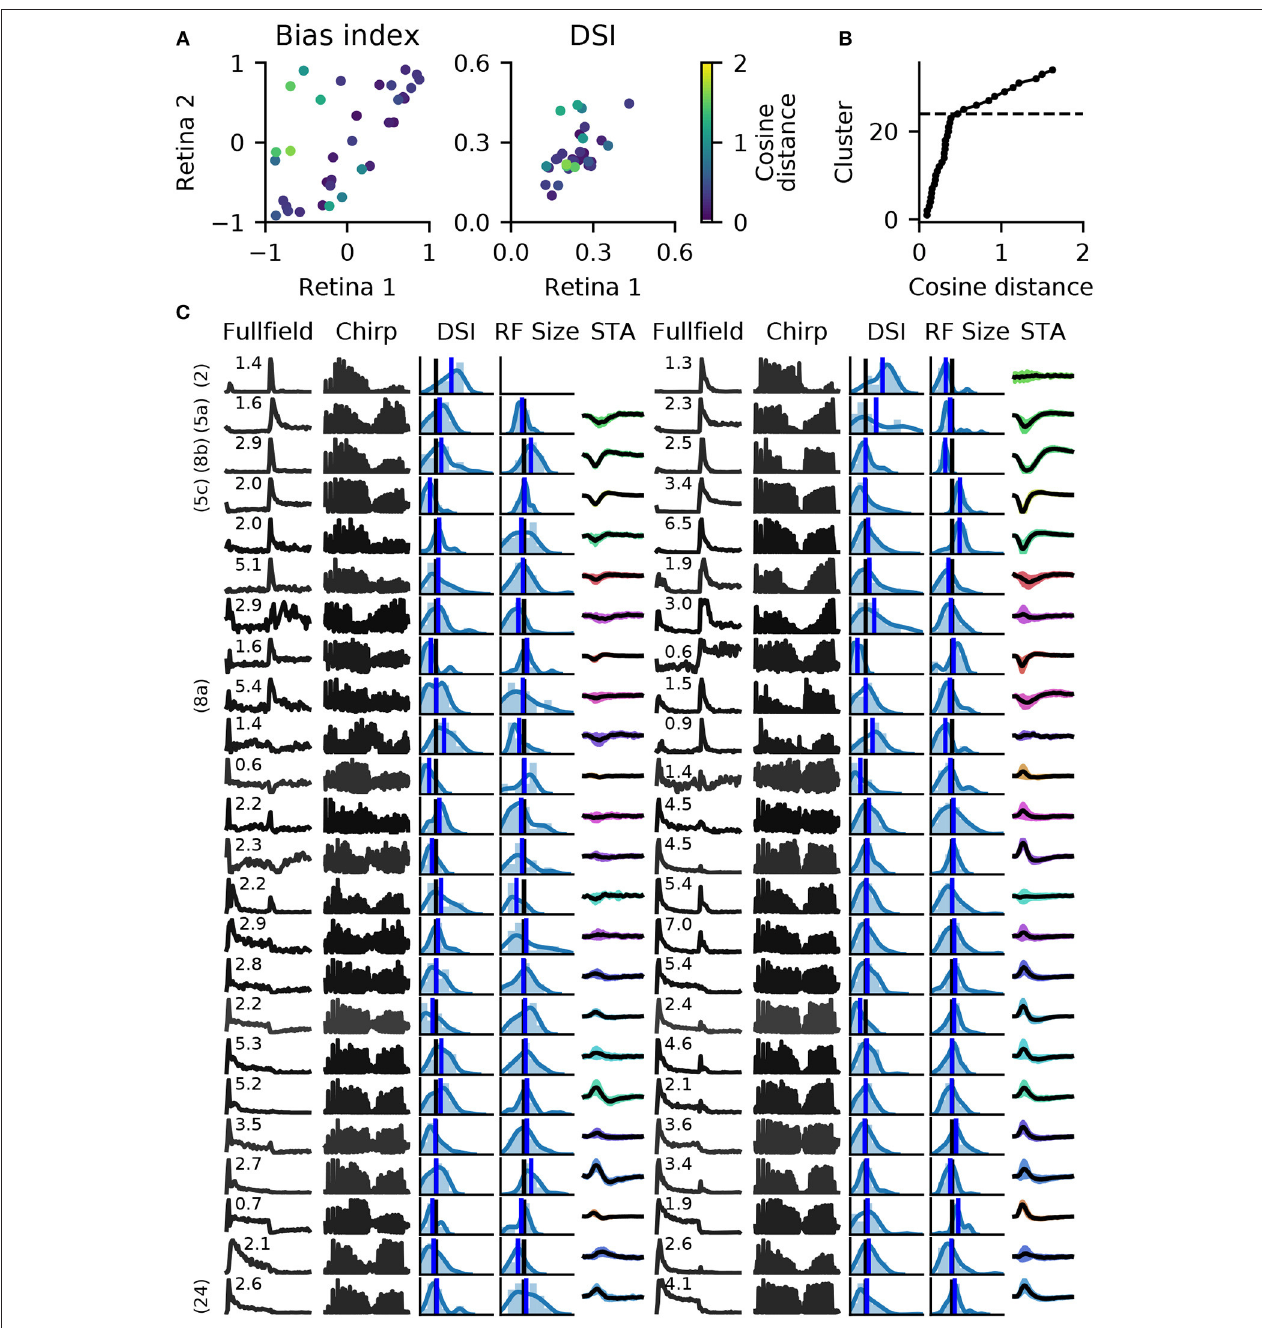
FIGURE 9 | Matching RGC types in two retinas. Spike trains from two retinas (retinas 1 and 2 in Figure 8 ) were independently clustered into 34 types, and matching pairs found using the cosine distance between vectors of length 20, obtained with RBF kernel PCA. (A) , A comparison of average bias indices (left) and direction selectivity (right) for each pair of RGC types. Color indicates the distance measure for each pair. (B) , Cumulative histogram of average pair distances. Beyond 24 clusters, a sharp increase in distance is observed. (C) , Main features of the 24 most similar RGC types for both retinas. Data is presented as in Figure 7 , with full field and chirp PSTHs, histograms of direction selectivity index (DSi) and receptive field size (black vertical lines are retina averages, blue line is the cluster average), and the STA (shaded area: 1 standard deviation; missing STA could not be fit). Numbers above the full field PSTHs are the percentage abundance of each RGC type. PSTHs are colored by cosine distance, with black indicating zero and gray higher values. On the left, clearly identified RGC types according to the taxonomy by Baden et al. (2016) are given.